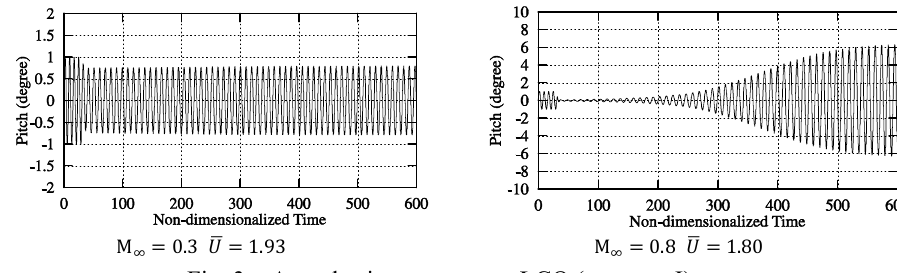
Fig. 3 Aeroelastic responses at LCO (test case